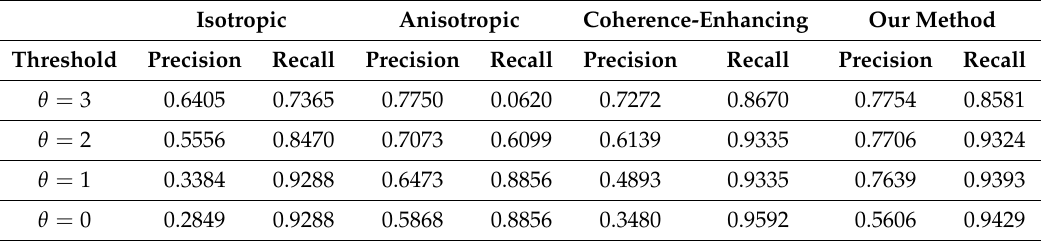
Figure 7. Quantitative comparison of the ROC curves for curvilinear structure detection in ( a ) an aerial image, and in ( b ) coronal, ( c ) axial, and ( d ) sagittal plane lung CT images. Our proposed algorithm (in blue color) is compared with the others, namely isotropic diffusion (in green color), anisotropic diffusion by proposed Perona–Malik (in red color), and coherence-enhancing diffusion proposed by Weickert (in pink color). Table 1. Quantitative evaluation of the detection of curvilinear structures corresponding to roads in aerial images and fissures in coronal, axial, and sagittal plane CT images in terms of precision and